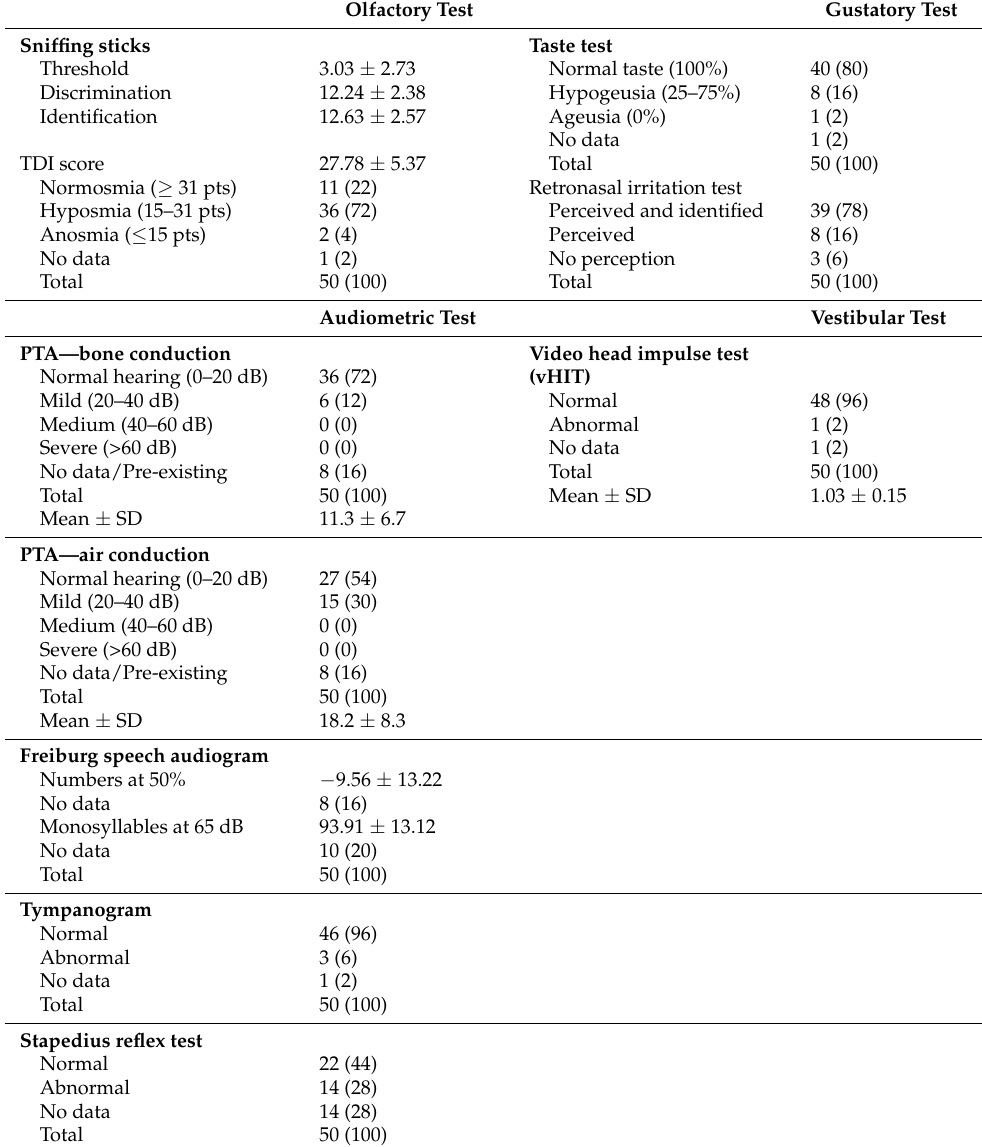
Table 3. Clinical test data of sensory dysfunction after COVID-19